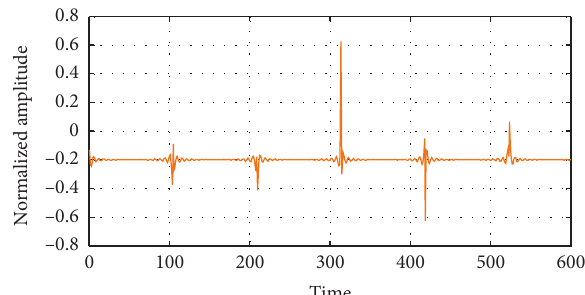
Figure 6: Waveform of music